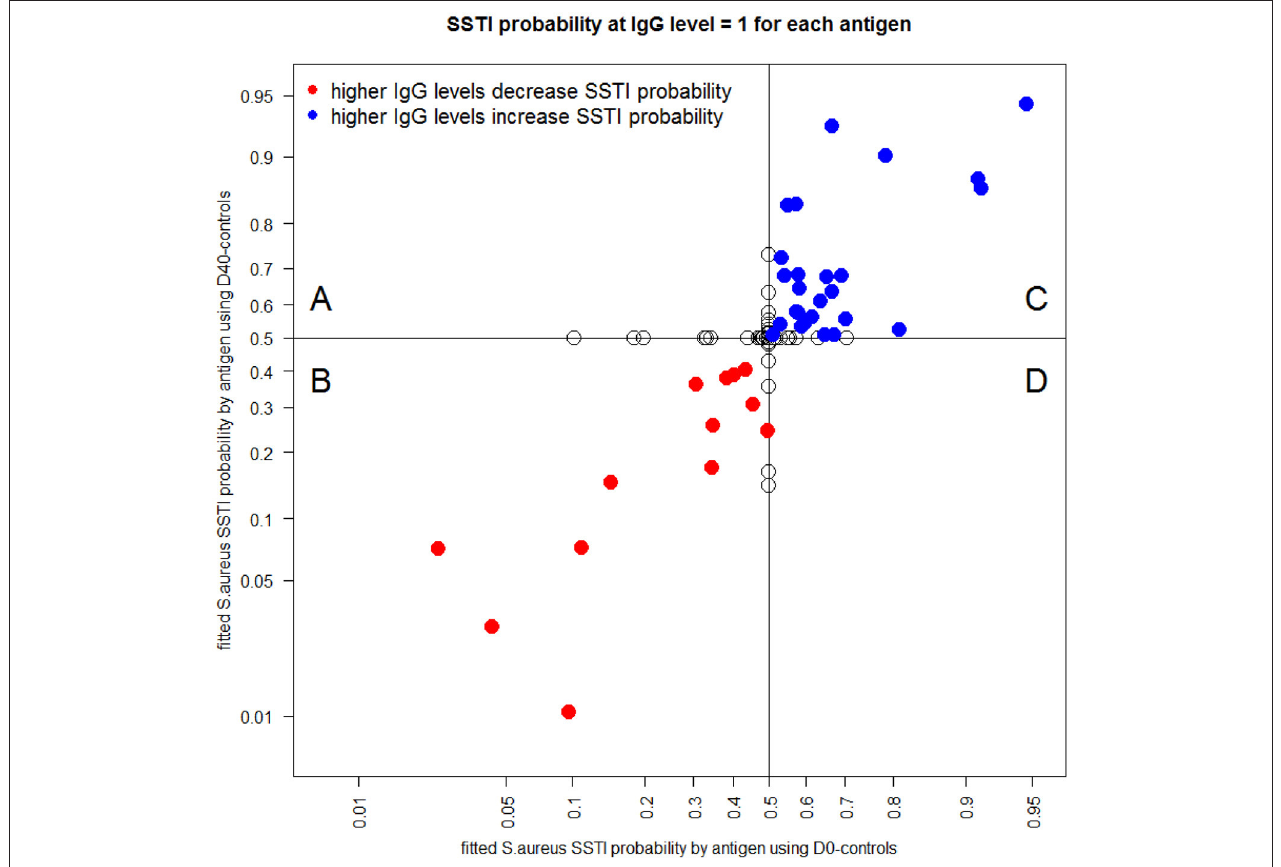
FIGURE 6 | Each dot depicts the S. aureus SSTI classification probabilities for the D0-controls (horizontal axis) and the D40-controls (vertical axis) when IgG is set to the value 1 µ g/mL for the corresponding antigen and IgG = 0 µ g/mL for all other antigens. Red circles [quadrant (B) ] mark antigens (see list in Table S1 ) which higher IgG levels were associated with a decrease in the SSTI classification probabilities both when comparing the D0 data and the D40 data to the controls. Blue circles [quadrant (C) ] represent antigens which higher IgG levels were associated with an increase in the SSTI classification probabilities. Empty circles [quadrants (A) and (D) ] identify antigens associated with antibody responses having no association with SSTI classification probability in one or both case-control